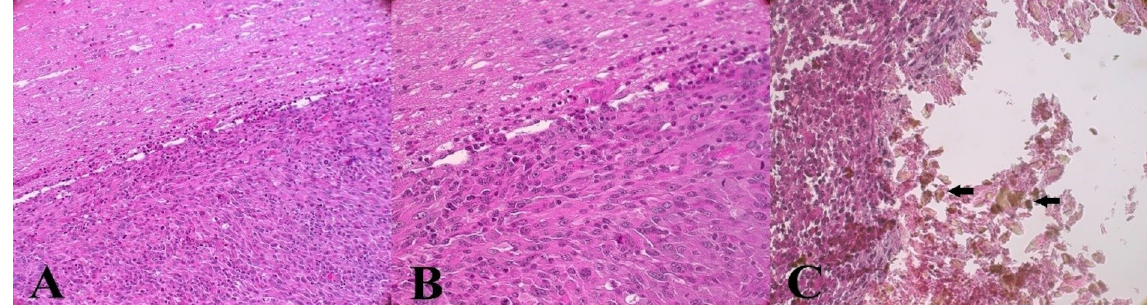
Fig 6. Microscopic findings of U87 tumor and injected 165 Ho. (A) The tumor is well delimited from the adjacent parenchyma, (B) it is highly cellular, and composed of polygonal to spindle cells. (C) Photo is taken without the condenser, to better show Ho crystals. Ho is visible within the tumor as lightly brown-gold, polygonal crystals